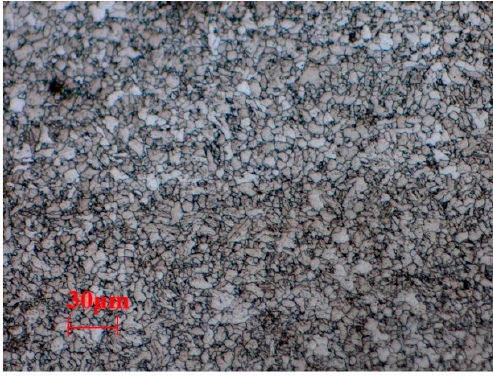
Figure 23. HESD repair welding.